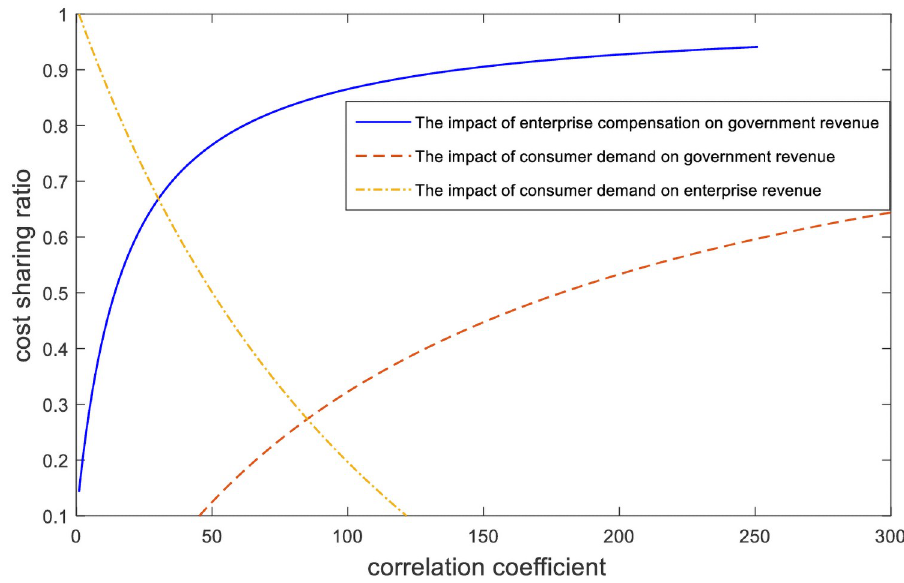
Fig 4. The influence of parameters on the proportion of sharing.